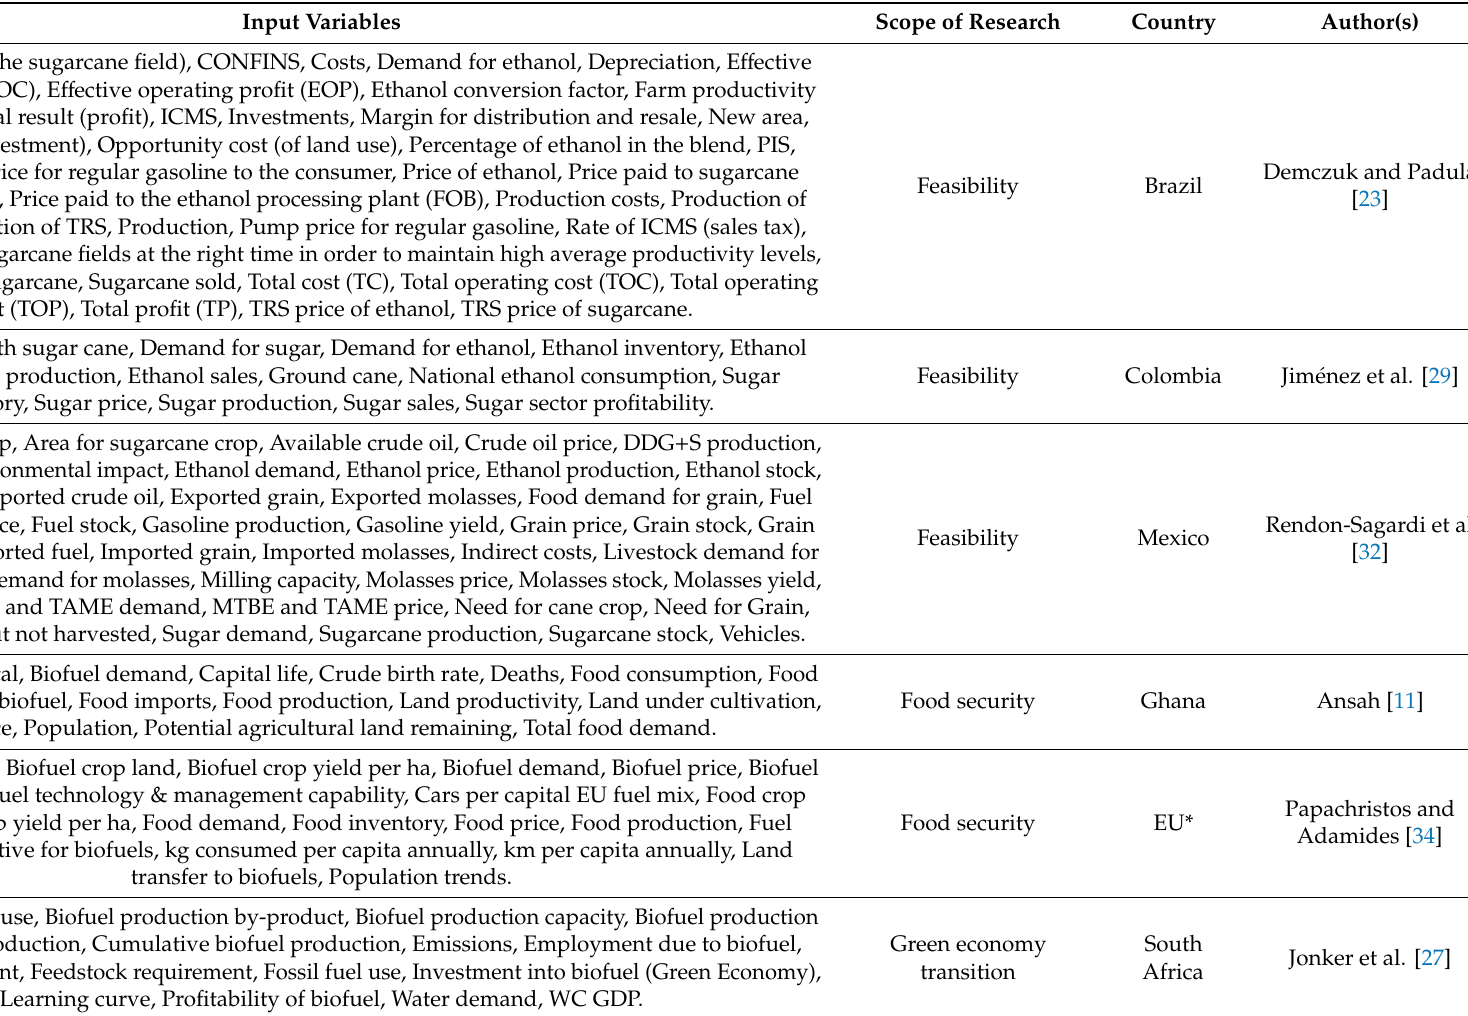
Table A2. Short summary of sources, applied in the